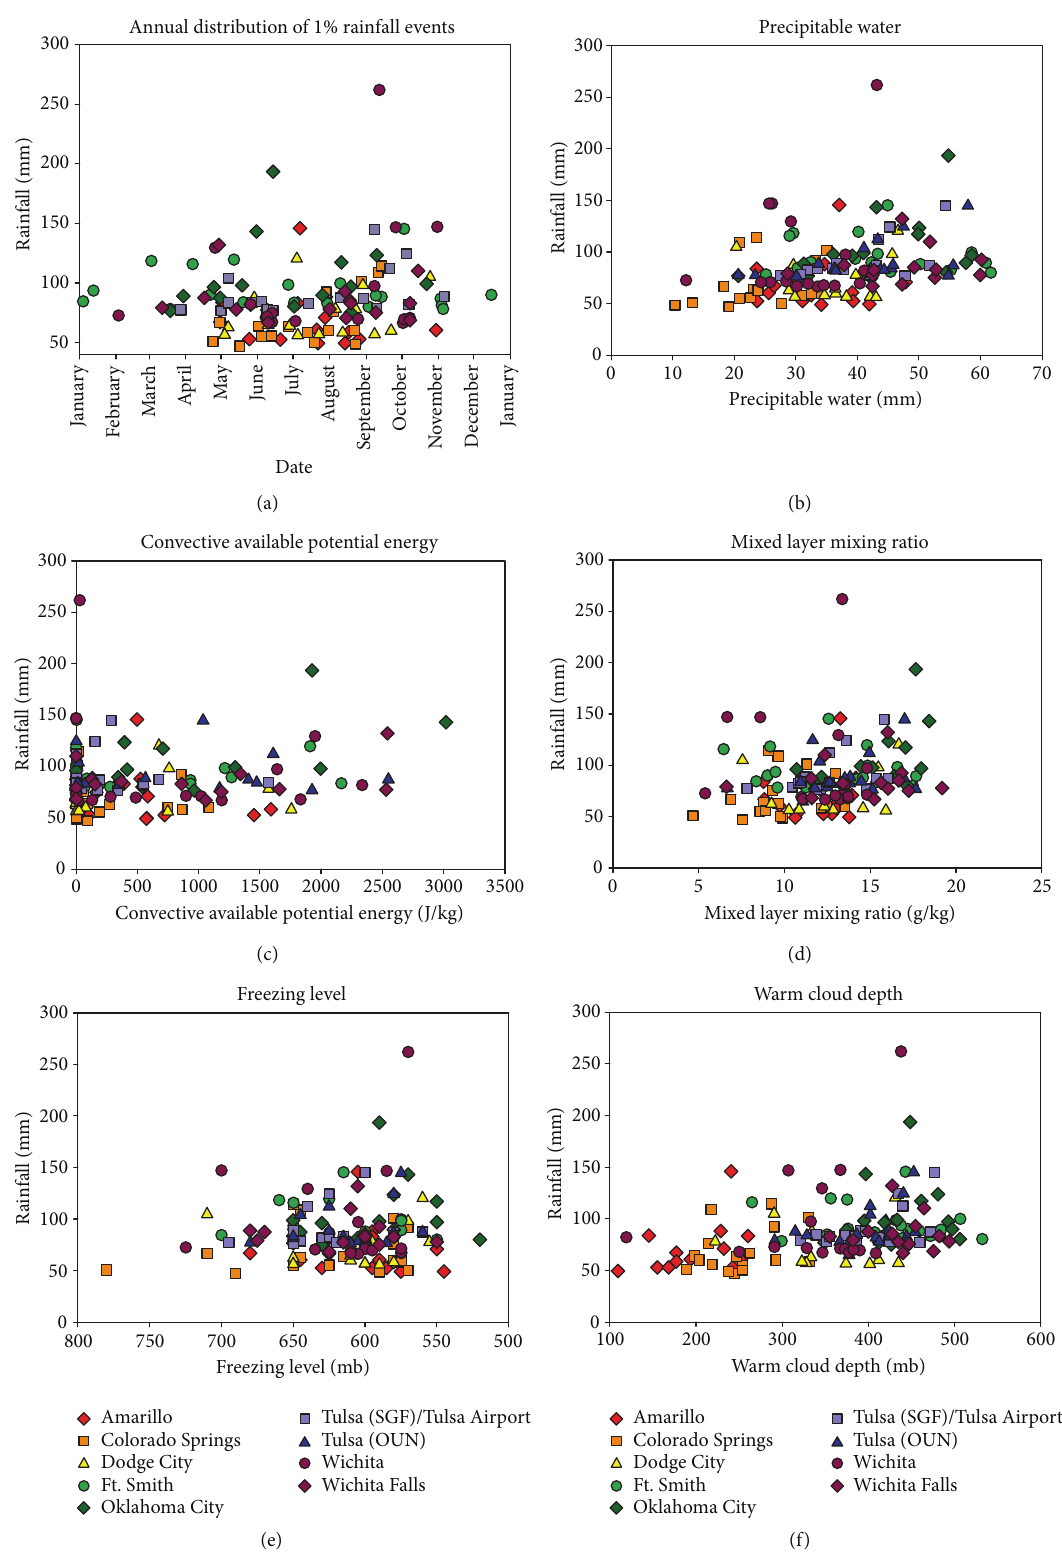
Figure 5: Basin composite graphs. (a) Annual distribution of 1% cases. (b) Magnitude of rainfall versus precipitable water. (c) Magnitude of rainfall versus CAPE. (d) Magnitude of rainfall versus MLMR. (e) Magnitude of rainfall versus warm cloud depth. (f) Magnitude of rainfall versus freezing